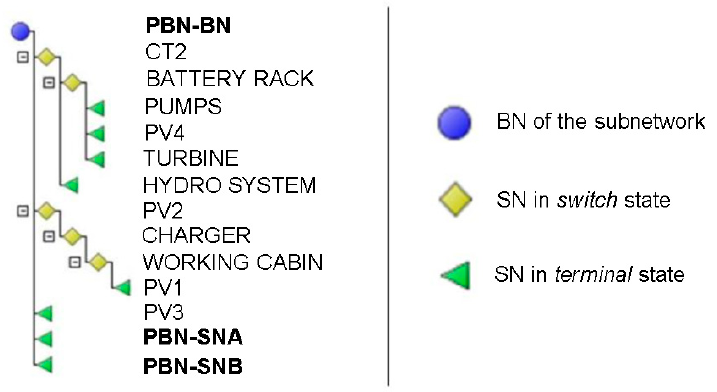
Figure 1. Example of subnetwork topology for the measurements.